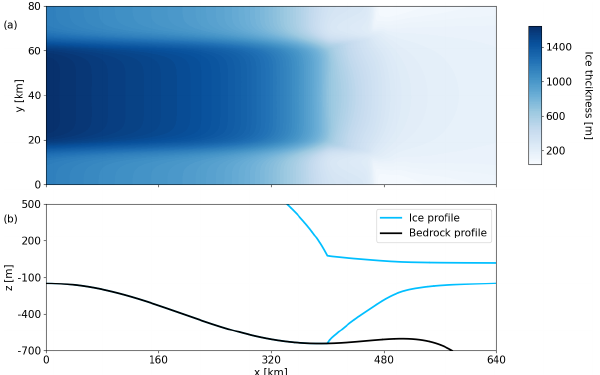
Figure 1. Initial steady-state configuration for the MISMIP+ exper- iments. (a) Ice thickness in (x,y) plane, (b) vertical profile along y =